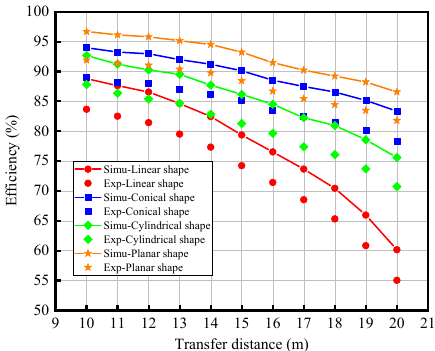
Figure 16. Comparison of simulation and experimental data of transmission efficiency among four